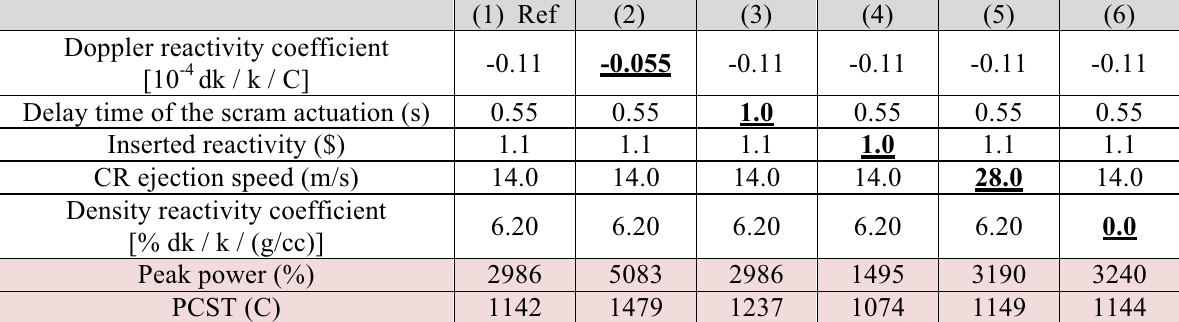
Figure 5: Plant behavior during CR ejection Figure 6: Sensitivity of the Doppler reactivity coefficients on PCST Table III: Summary of sensitivity analyses for CR ejection at full power